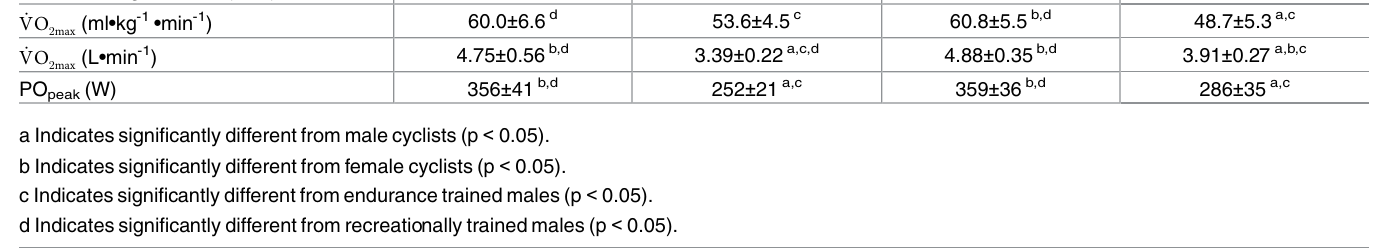
After three minutes of seated rest, subjects started at a workload of 1.5W (cid:1) kg -1 (85–145W), which was increased with 0.5W (cid:1) kg -1 every three minutes (30–50W (cid:1) 3min -1 ) until voluntary exhaustion. Trained cyclists performed two maximal incremental tests on separate days to assess reproducibility of NIRS signals and exercise thresholds. The test was terminated if cadence dropped below 80 rpm, despite verbal encouragement. Active cool-down consisted of five minutes cycling at 1 W (cid:1) kg -1 (60–100W). Thereafter, an arterial occlusion was performed to assess maximal desaturation of the m. vastus lateralis. Hereto, a pressure cuff was inflated to approximately ~300mmHg at the most proximal part of the thigh until maximal desaturation from unwrapping [34].